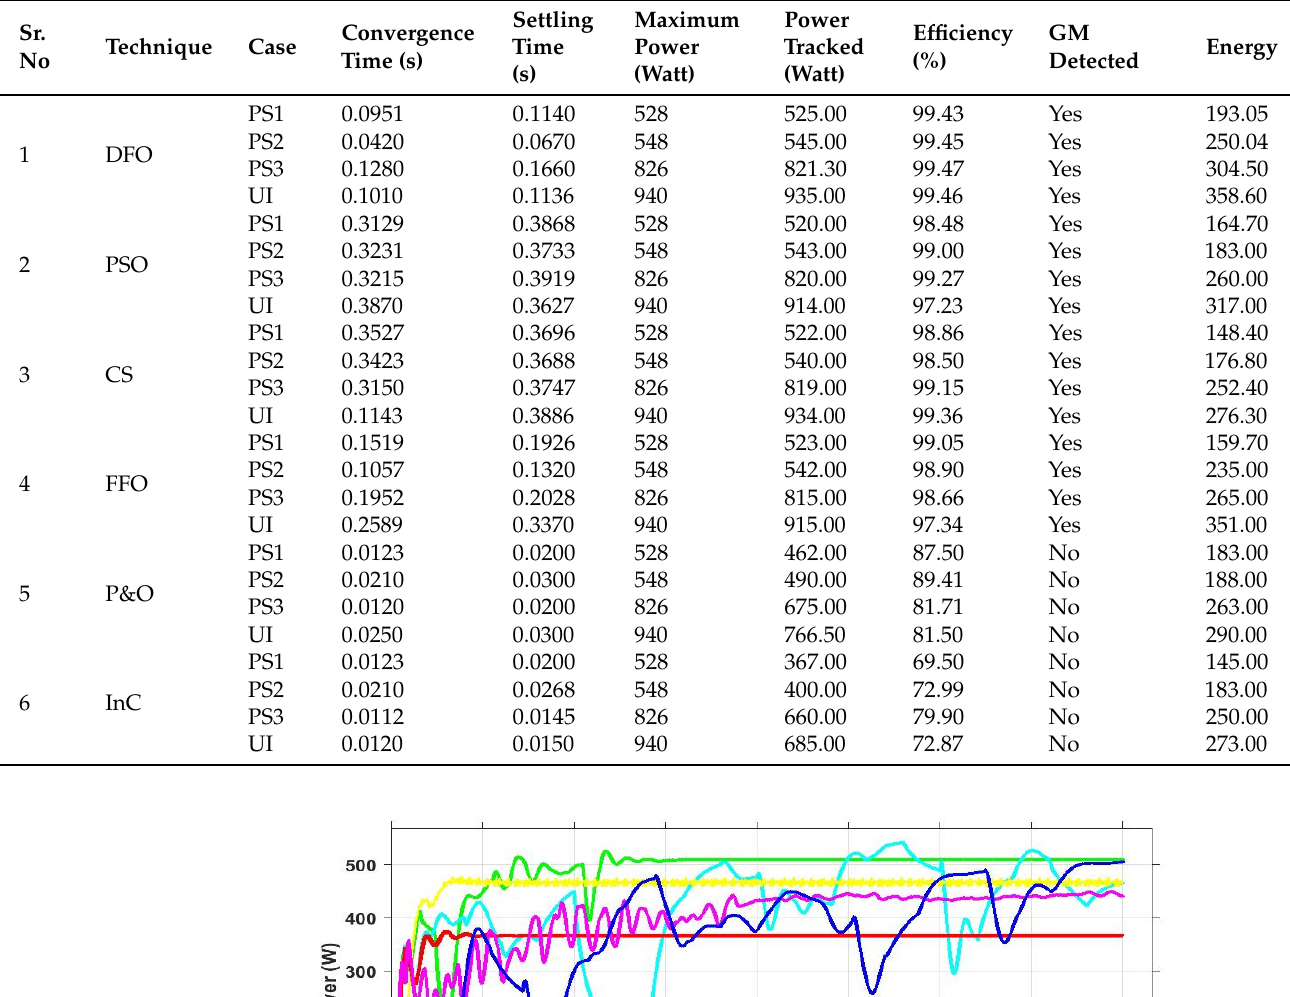
Table 5. Comparative analysis of DFO with PSO, CS, FFO, P&O AND InC MPPT Algorithm for UI and PS Conditions for MLPE distributed PV system.